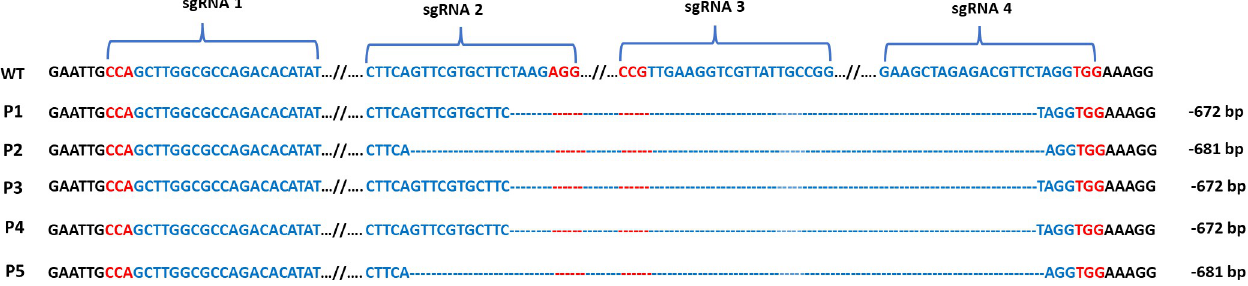
Fig 7. Sanger sequencing results of PDS gene derived from agroinfiltrated cowpea leaves. The sgRNA1, sgRNA2, sgRNA3 and sgRNA4 positions are indicated. PAM sequences are highlighted in red letter. WT indicates wild type that was not edited. Dash lines ( — ) are the deleted nucleotides and one substitution bp shows as a green letter in